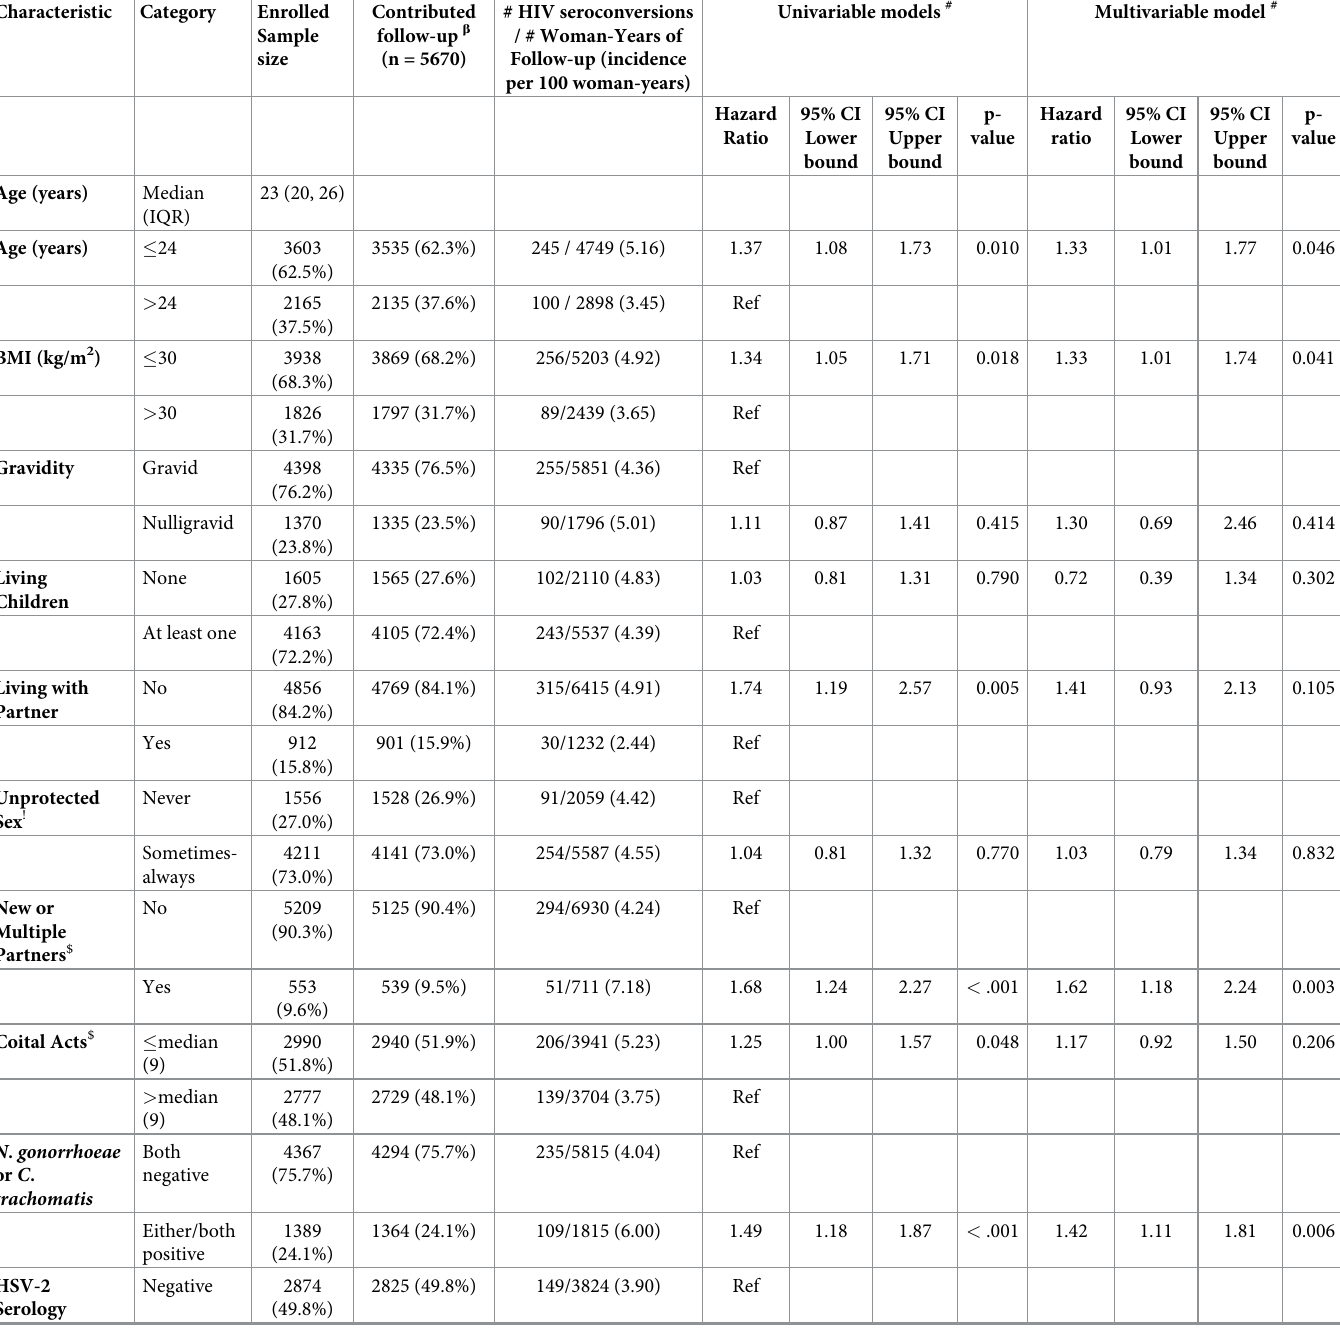
Table 1. Baseline socio-demographic, behavioural characteristics and HIV seroincidence—Individual and multivariable model results.